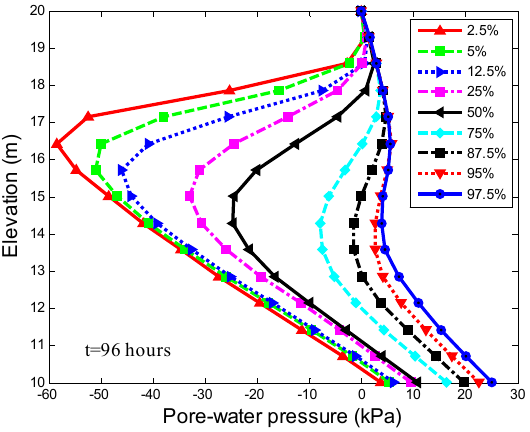
Figure 9. Pore-water pressure profiles in slopes with different percentiles of SWCC (t = 96 h).